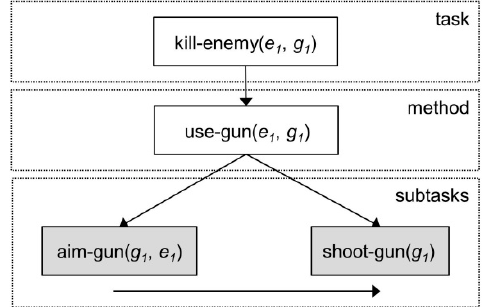
Figure 6. Depiction of the decomposition of task kill-enemy (i.e., kill the enemy e 1 using gun g 1 ) into the subtasks aim-gun ( g 1 , e 1 ) and shoot-gun ( g 1 ) via the hierarchical task network (HTN) method use-gun . In this case the agent must first aim the gun before shooting it at the enemy. The order of precedence is depicted by the rightward-pointing arrow. This decomposition forms an AND branch of the decomposition tree. A decomposition tree is a tree structure that represents derivations of plans and results from the combination of these AND-branches.